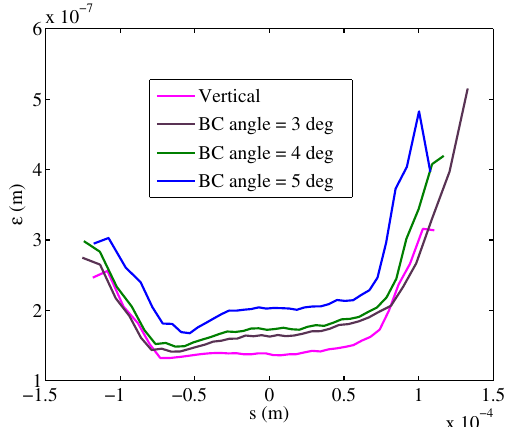
FIG. 13. Simulated horizontal slice emittance along the bunch for different bending angles of the dipoles in the magnetic chicane (BC angle). The compression factor is fixed to